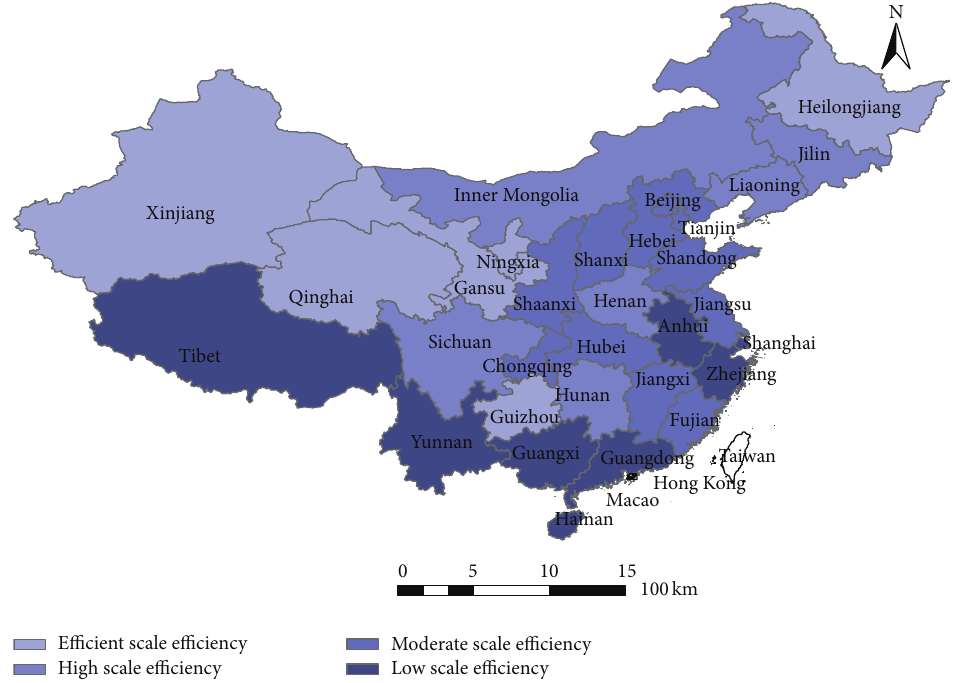
Figure 3: Spatial distribution of scale efficiency of intensive agricultural production in